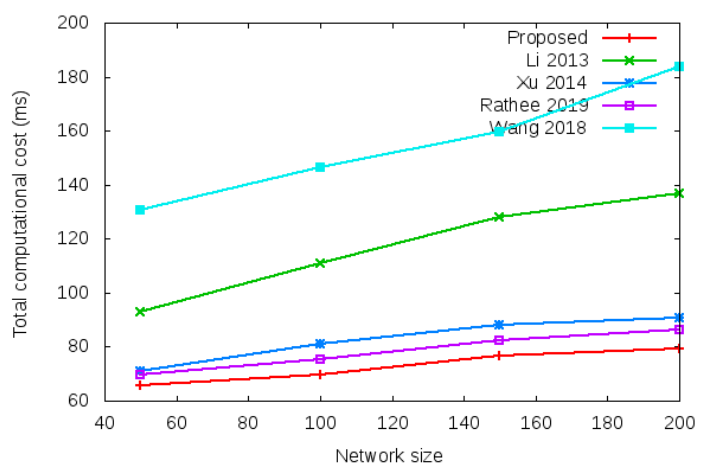
Figure 5. Total computational cost of proposed protocol vs. existing protocols with different network size of 50, 100, 150, and 200 nodes during login authentication